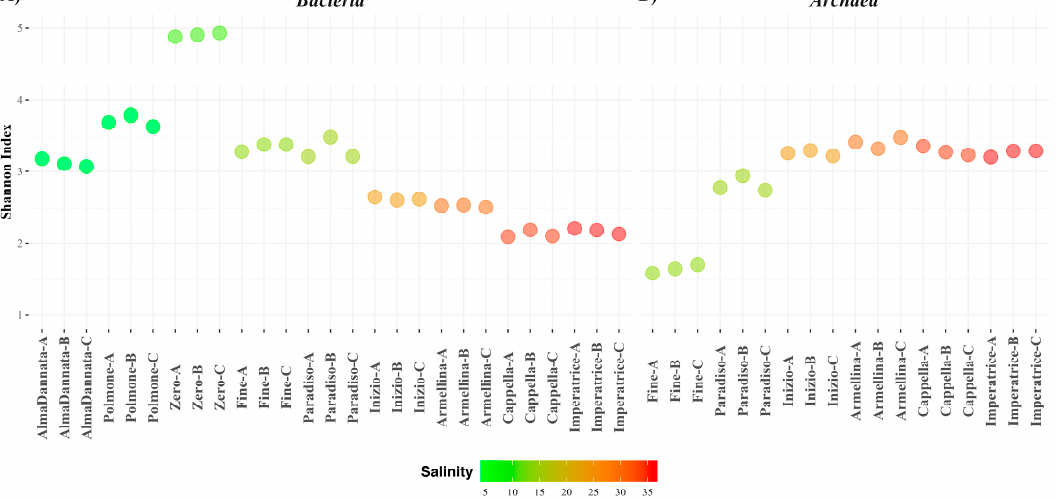
Figure 2. Shannon index inferred from 16S rRNA gene amplicon sequences for the assayed ponds of the MdS saltern. Ponds are plotted according to increasing salinity: from Alma Dannata to Imperatrice for Bacteria ( A ) and from Fine to Imperatrice for Archaea ( B ). The letters A, B and C accompanying the names of the ponds refer to the values of the experimental replicas. Salinity is expressed as salt percentage (w/v).